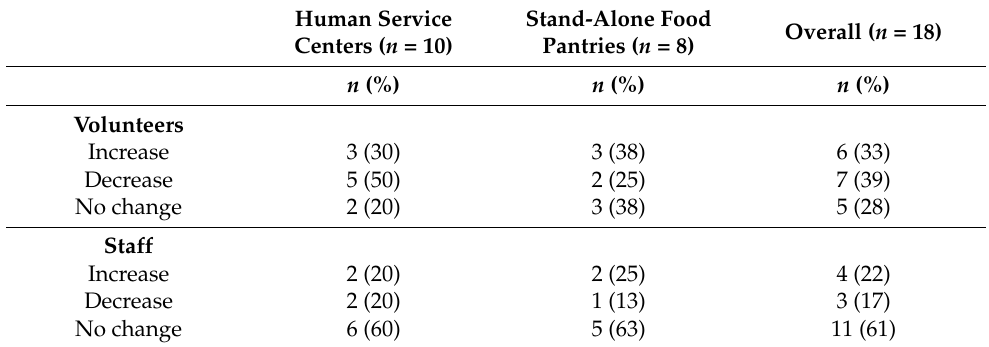
Table 3. Overall changes in numbers of staff and volunteers during COVID-19 by type of EFAOs. Human Service Stand-Alone Centers ( n = 10)